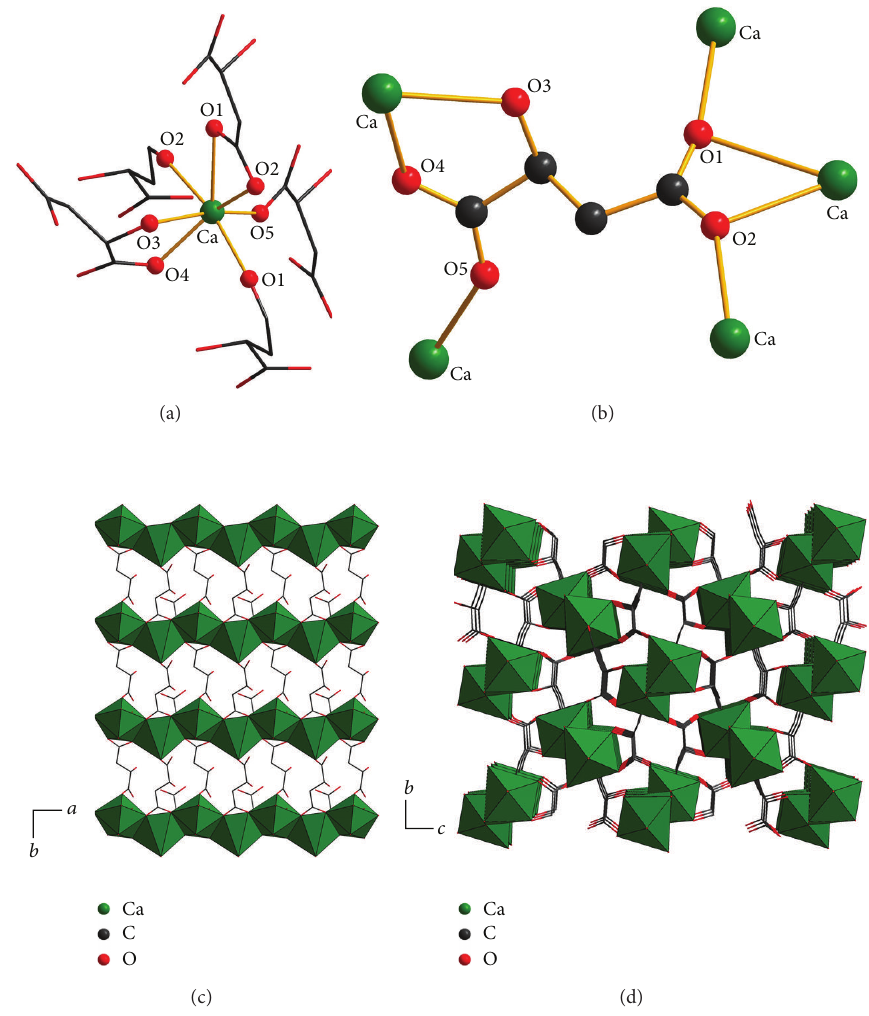
Figure 3: (a) The coordination spheres of calcium atom in the complex. (b) The coordination mode of the ligand in the complex. (c) The edge-sharing 2D layer in the complex. (d) The 3D network viewed along the a -axis (H atoms were omitted for